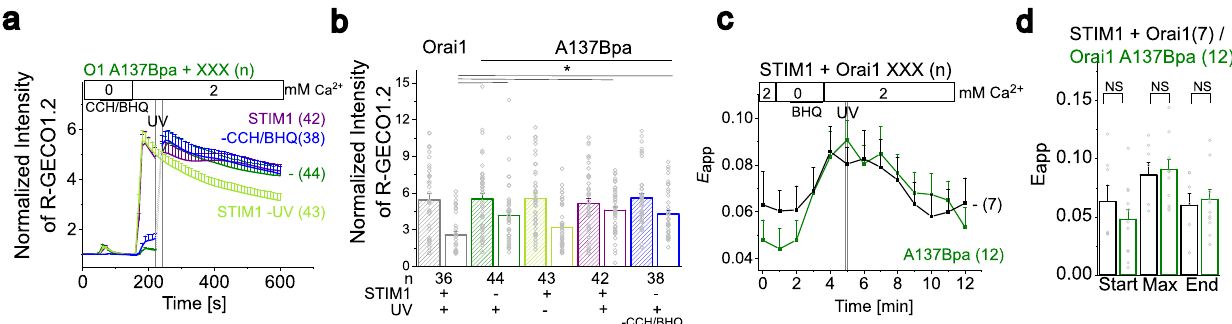
Fig. 5 | Photocrosslinking induced Orai1 activation delays the return to the resting state and leaves STIM1 coupling unaffected. a Ca 2+ imaging measure- ments showing intracellular Ca 2+ levels, representedby the normalizedintensityof R-GECO1.2 co-transfected with Orai1 A137Bpa either without or with STIM1, while switchingfroma0mMCa 2+ toa0mMCa 2+ /100 µ MCCH/50 µ MBHQand fi nallytoa 2mM Ca 2+ -containing solution. Blue trace shows Orai1 A137Bpa currents without 100 µ M CCH/50 µ M BHQ application. UV light was applied for 10s to cells expres- sing Orai1 A137Bpa or STIM1+Orai1 A137Bpa and compared to STIM1+Orai1 A137Bpa evokedCa 2+ levelsin the absenceof UV light. b Summarizing bardiagram comparing Ca 2+ levels in ( a )and ofSTIM1+wild-type Orai1atmaximallevelsand